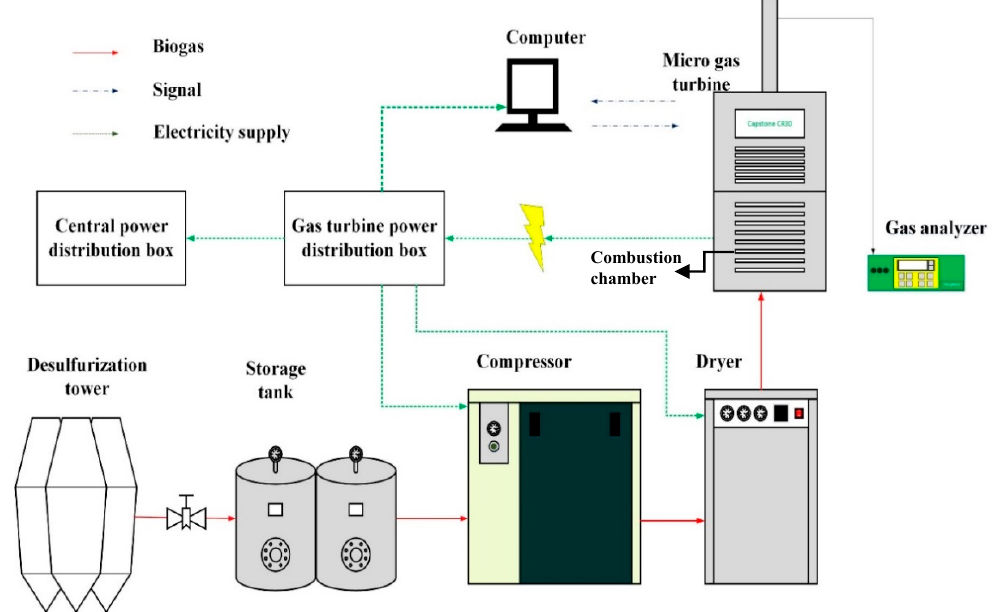
Figure 1. The process of biogas application in combination with a CR-30 micro gas turbine electricity generator.